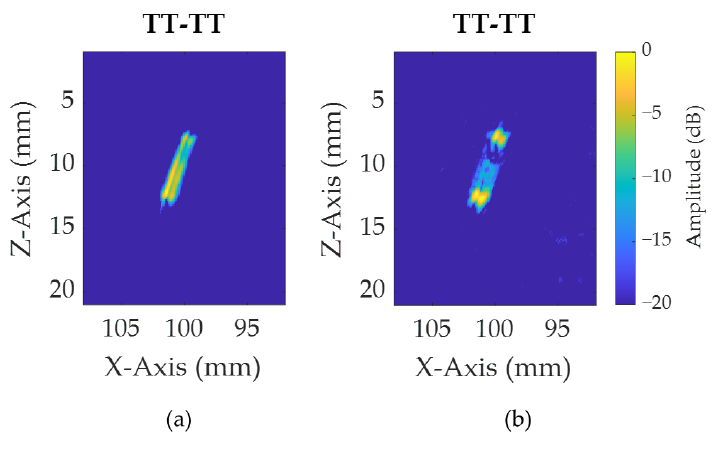
Figure 14. TT–TT views of notch C for ( a ) TFM and ( b )